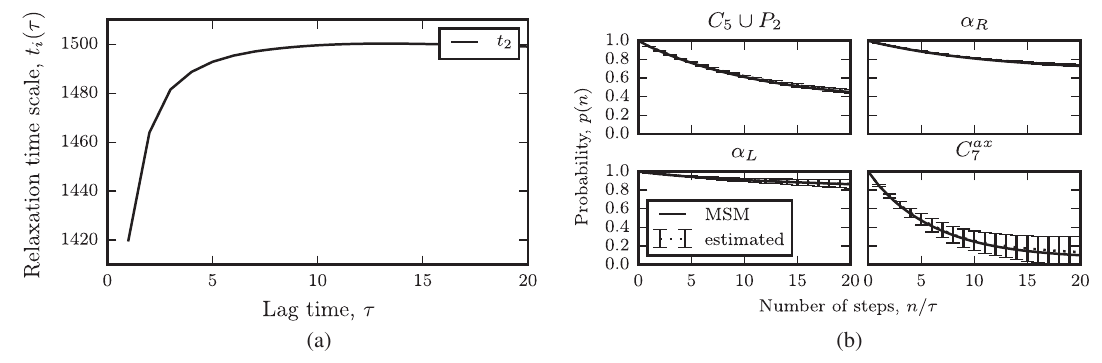
FIG. 12. (a) Implied time-scale test. Convergence of the largest relaxation time scale t 2 indicates a good Markov model fit; i.e., the slow eigenfunction of the associated dynamical operator is well approximated. (b) The Chapman-Kolmogorov test validates the Markov assumption by comparing the evolution of self-transition probabilities predicted by the MSM parametrized at lag time τ with direct estimates from the data at larger lag times n τ .